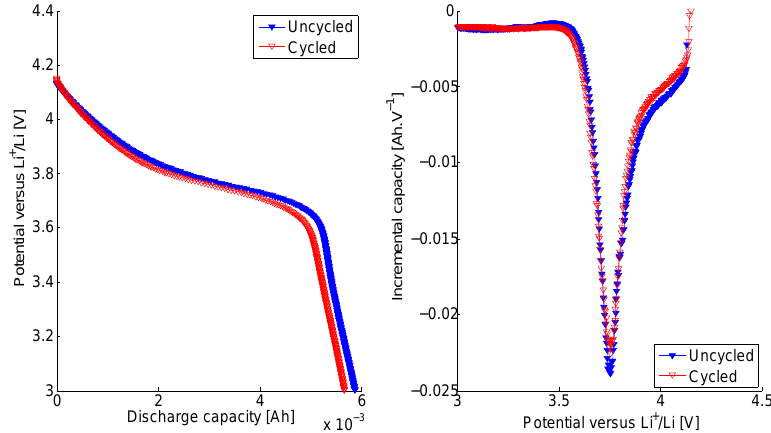
Figure 3. ( Left ) NMC potential versus discharge capacity; ( Right ) NMC incremental capacity during lithiation processes.